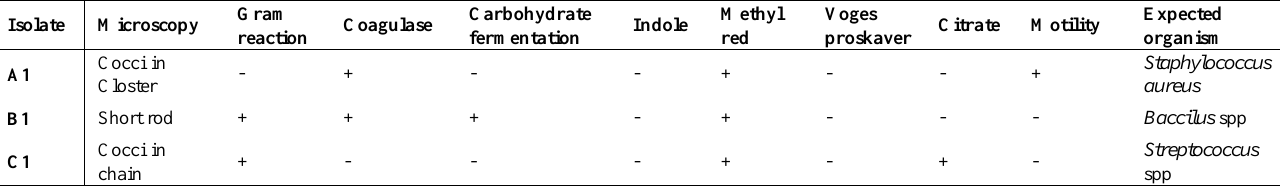
Key: + = presence; - = Absence The fungal species isolated as presented in Tables (6 and 7) were Penicillium spp, Mucor hiemalis, Aspergillus species and Rhizopus spp . On biochemical tests, the bacterial